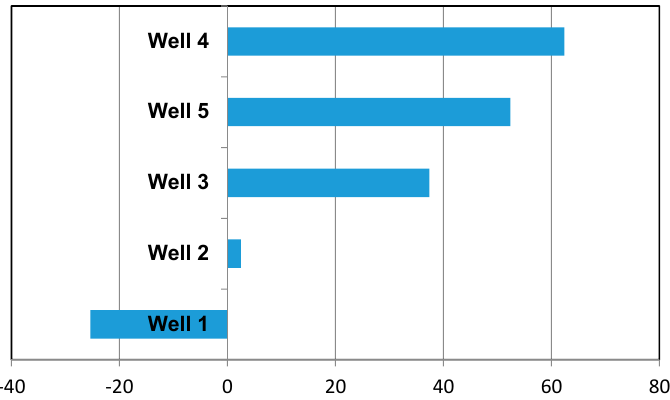
Figure 8. Maximum NPV for five wells drilled in Babbage Field.